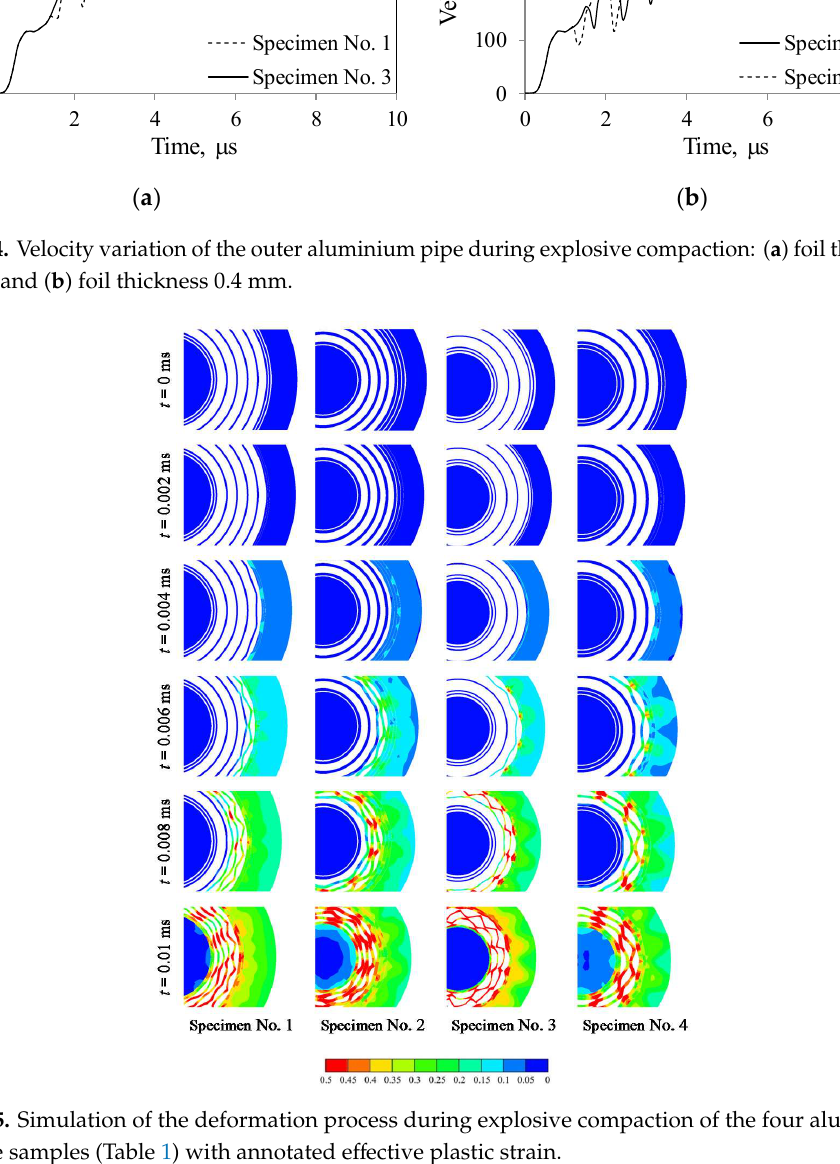
Figure 4. Velocity variation of the outer aluminium pipe during explosive compaction: ( a ) foil thickness 0.2 mm and ( b ) foil thickness 0.4 mm